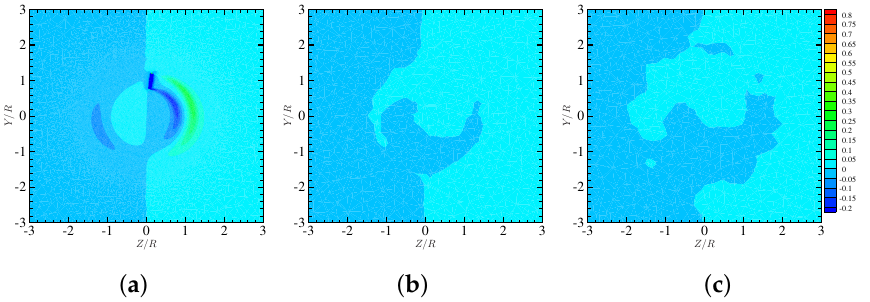
Figure 8. The distribution of the instantaneous, dimensionless lateral (or Z -component) flow ve- locity, W / U ∞ , in the YZ -plane at different axial distances from the plane of rotation: ( a ) X / R = 0, ( b ) X / R = 2, and ( c ) X / R =